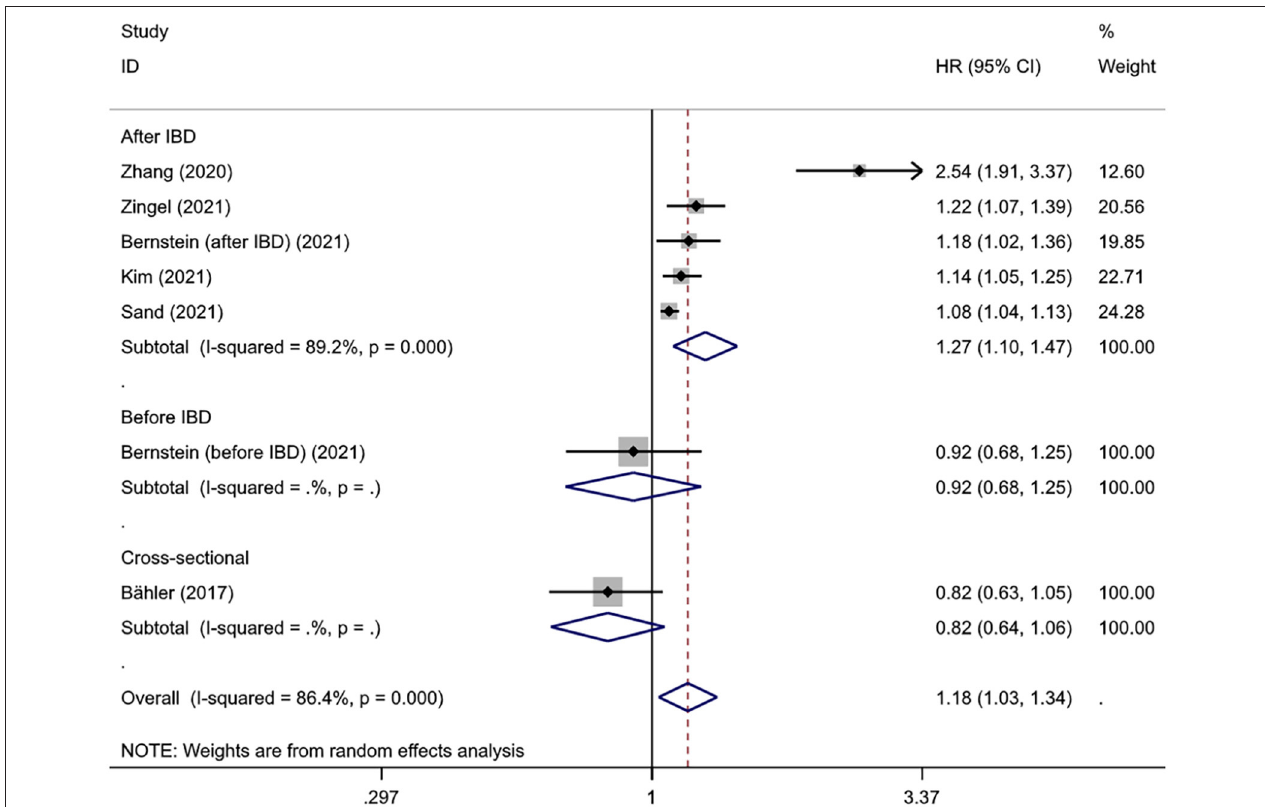
FIGURE 3 | The results of temporal relationship between inflammatory bowel disease and dementia.